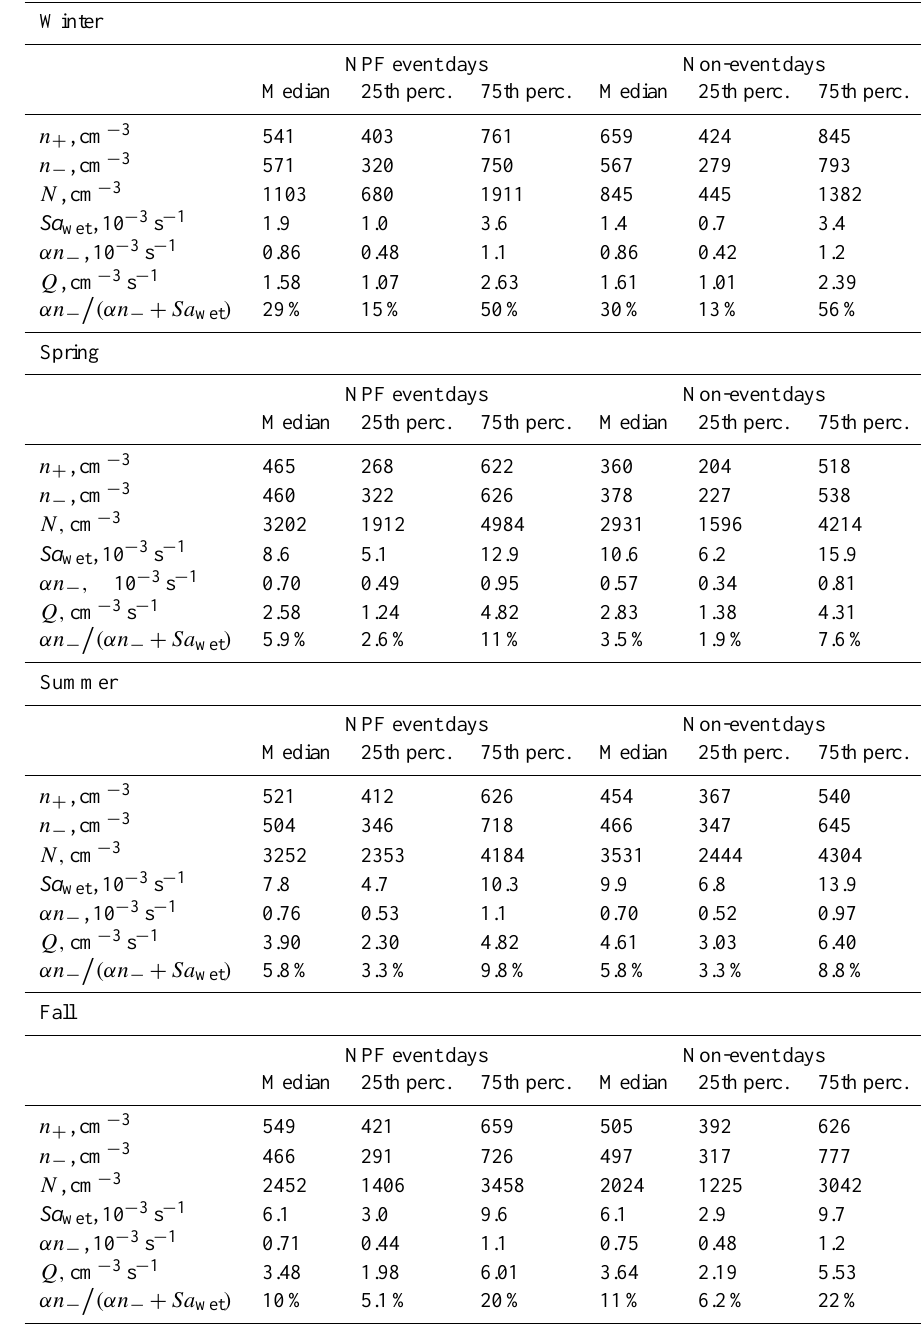
Table 5. Statistical values of the wet aerosol ion sink ( Sa wet ), the ion loss due to ion recombination ( α n + ), the positive and negative cluster ion concentrations ( n + and n − , respectively) the total concentration of aerosol particles ( N ), the ionization rate ( Q ) and the ratio of ion loss due to recombination to total ion loss ( α n + /( αn + + Sa wet )). All the values are given for RH<90% and were calculated from hourly medians. February 2007–February 2012, Puy de